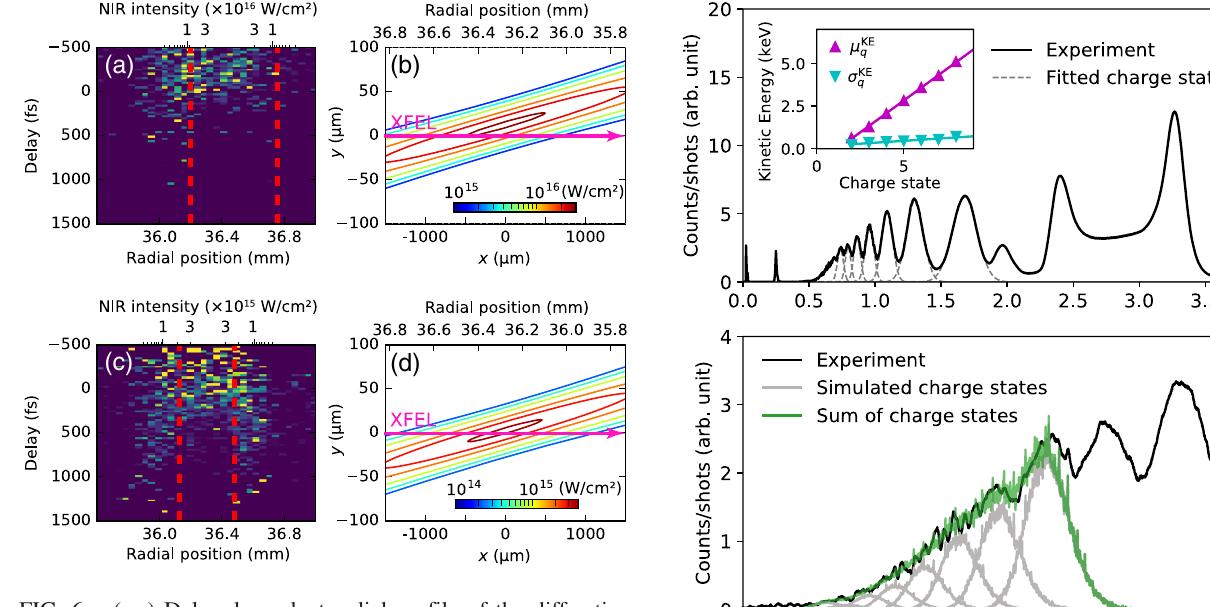
FIG. 6. (a,c) Delay-dependent radial profile of the diffraction intensities around the f 111 g peak at (a) I NIR ¼ 3 × 10 16 W = cm 2 fcc peak and (c) I NIR ¼ 4 × 10 15 W = cm 2 . The upper axis indicates the peak estimated NIR intensity at the interaction region. (b,d) Top view FIG. 7. (a) Ion TOF spectrum of NIR-irradiated Xe clusters at of the spatial intensity distribution of the NIR laser at I NIR ¼ 4 × 10 15 W = cm 2 . The spectrum was fitted with a sum of peak Gaussian functions (dotted lines). Inset: correlation between the charge state and the ion kinetic energy. (b) Experimental spec- trum fitted with the sum of the charge-state-resolved spectra simulated with an ion optics simulation